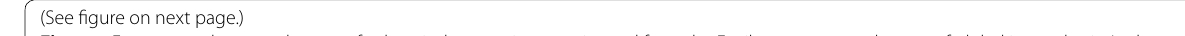
Their time span in MLT is given within